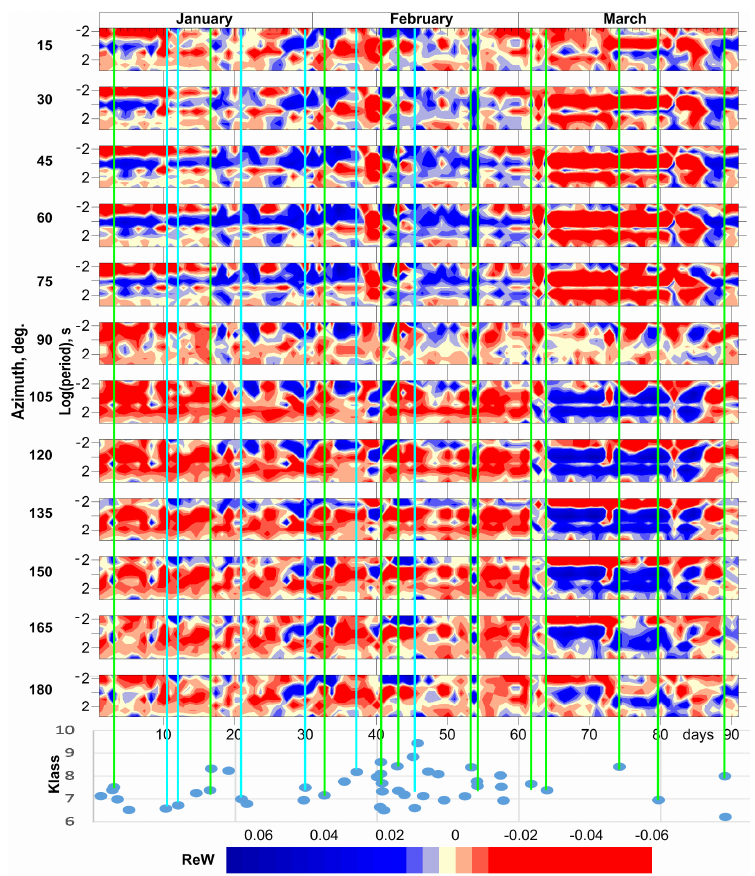
Figure 5. Time-frequency series of azimuth MT-monitoring (tipper variations) for Chon- Kurchak station in comparison with seismicity for January-March 2016 (ovals - seismic